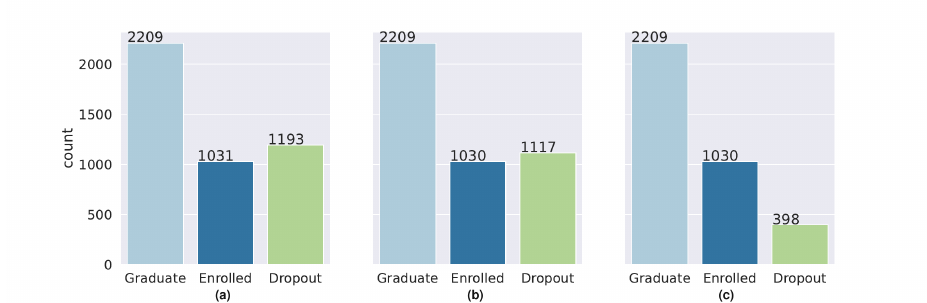
Figure 1. Distribution of the records among the three defined labels and for the datasets built with: ( a ) information at the time of enrollment (S0); ( b ) information at the end of first academic semester (S1); ( c ) information at the end of second academic semester